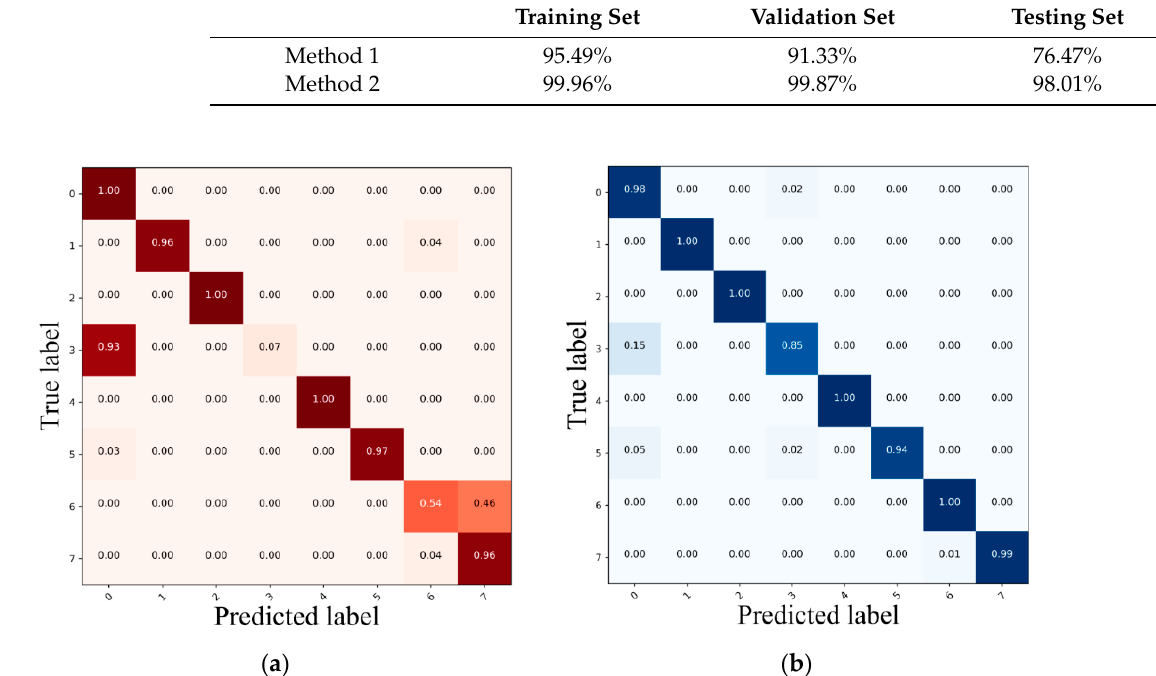
Figure 15. The identification accuracy rate of the two methods in the testing set: ( a ) Method 1; and ( b ) Method 2.